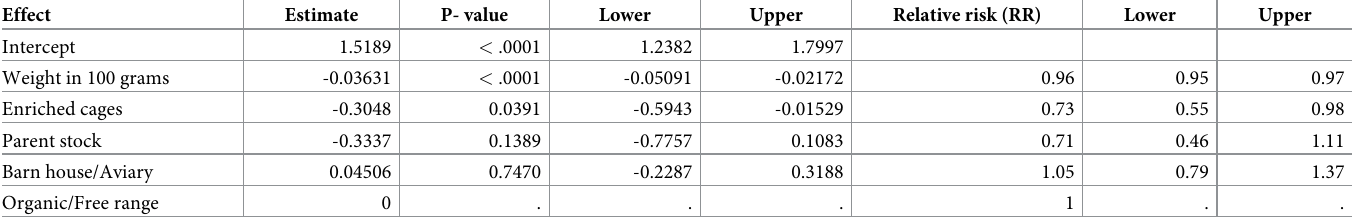
Table 13. Overview of the effects of body weight (BW) and the interaction of BW and production system on the number of KBF. Results from the generalized, linear mixed model.